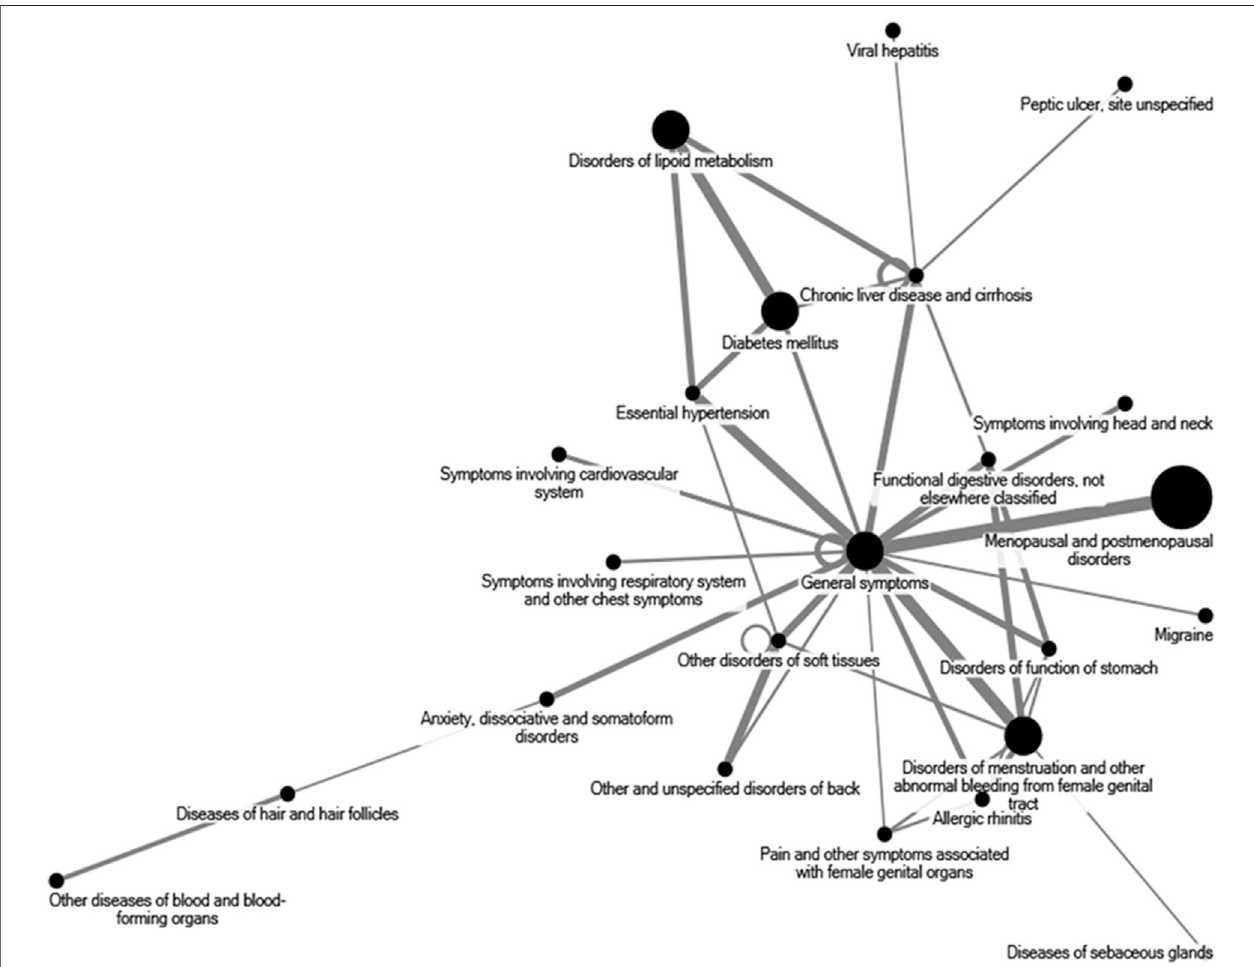
FIGURE2| Thecorepatternofdiseaseandsingleherbusageforradix Salviamiltiorrhiza .Thetop50diseaseforradix Salviamiltiorrhiza usepatientswereanalyzed through open-sourced freeware NodeXL.